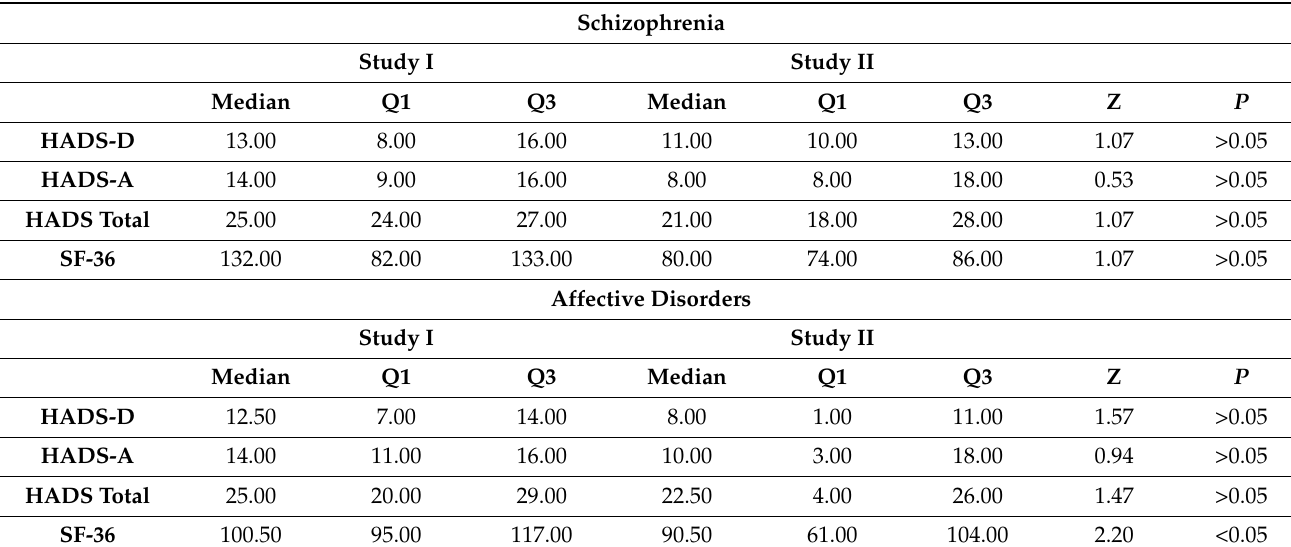
Table 5. Results achieved by patients on the HADS and SF-36 scale during the first and second tests according to a diagnosis (Wilcoxon